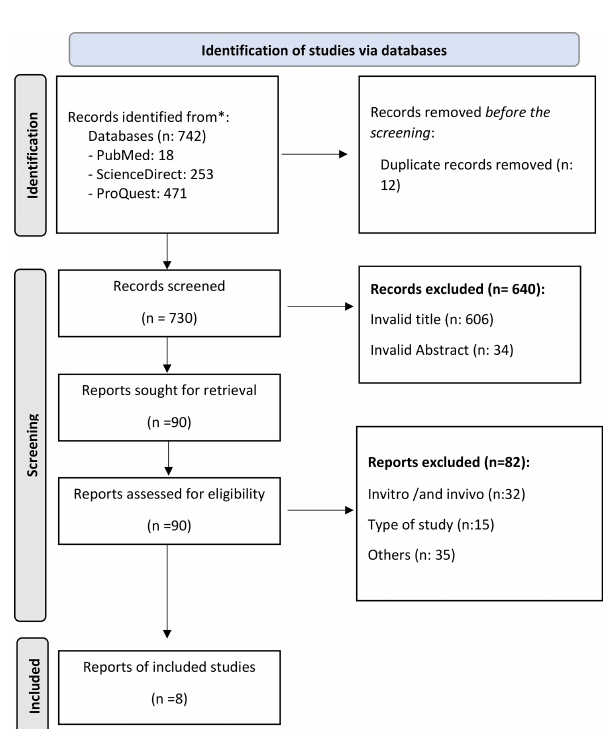
Figure 1. An example of accurate data representation and universal readability of